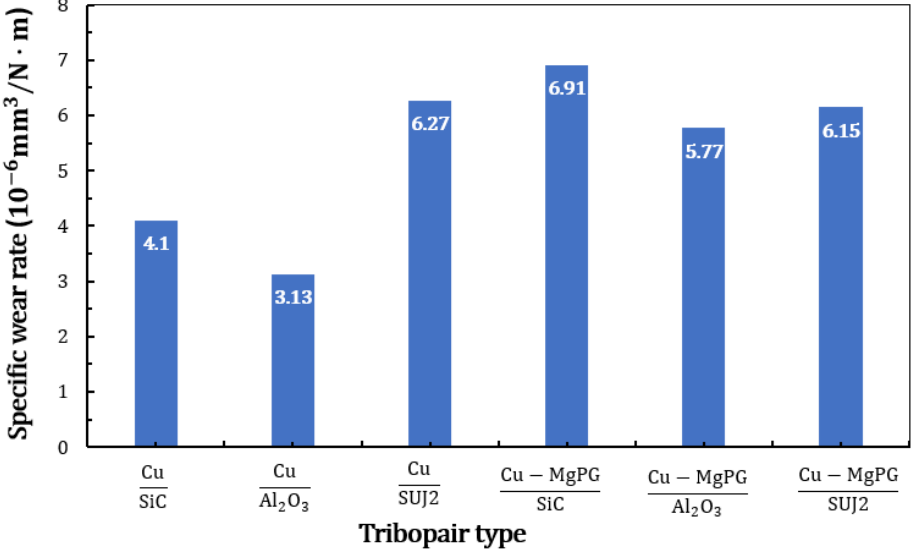
Figure 6. Average specific wear rate of the sintered disc against SiC, Al 2 O 3 , SUJ2 counterbodies. For the sintered copper disc, the lowest wear rate disappeared when sliding against Al 2 O 3 counterbody, which is similar to the relationship of the friction coefficient. How- ever, the highest WR disappeared when sliding against SUJ2 counterbody that is different